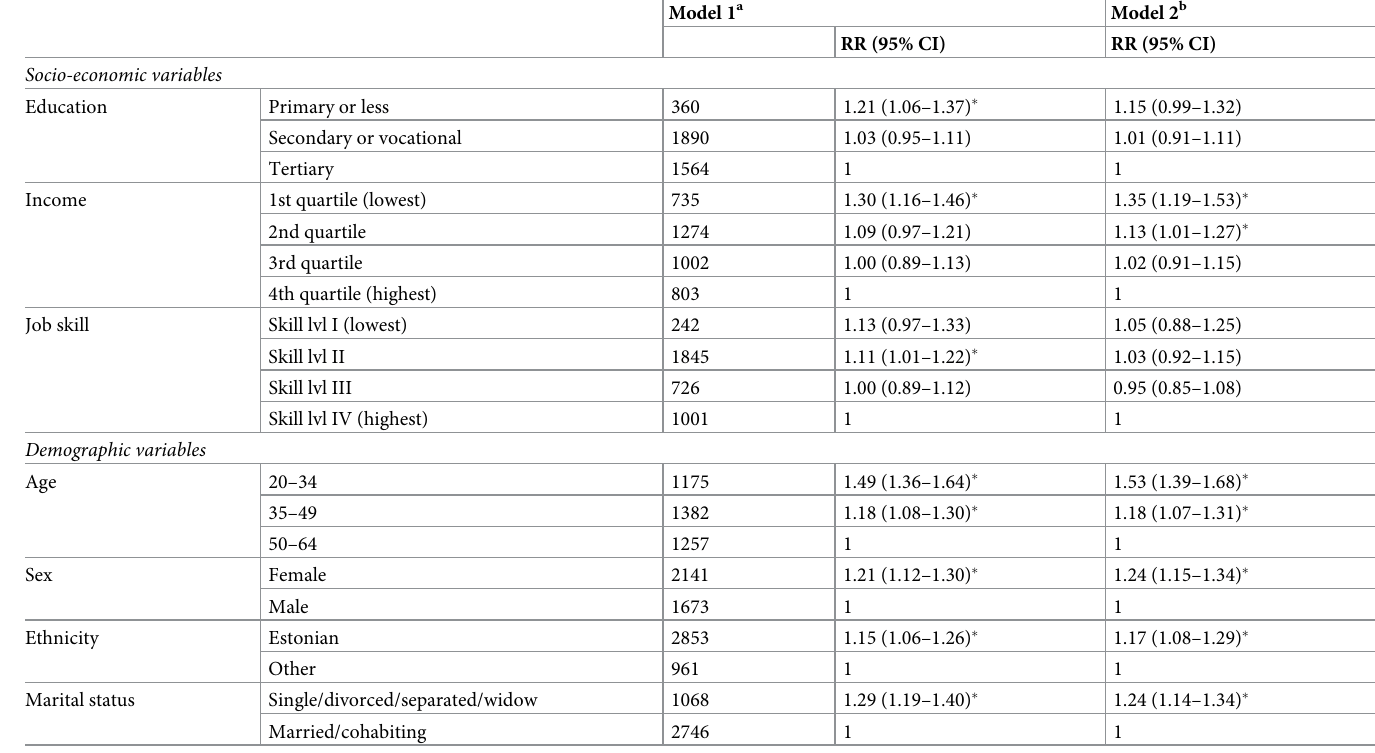
Table 6. Association of co-existing mental health complaints by socio-economic and demographic variables, rate ratios with 95%